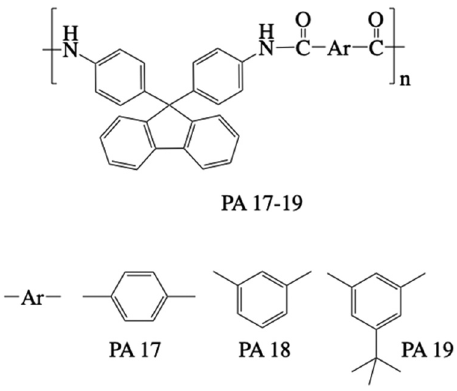
Figure 6: PAs having cardo fl uorene derivatives ( 63 ) .